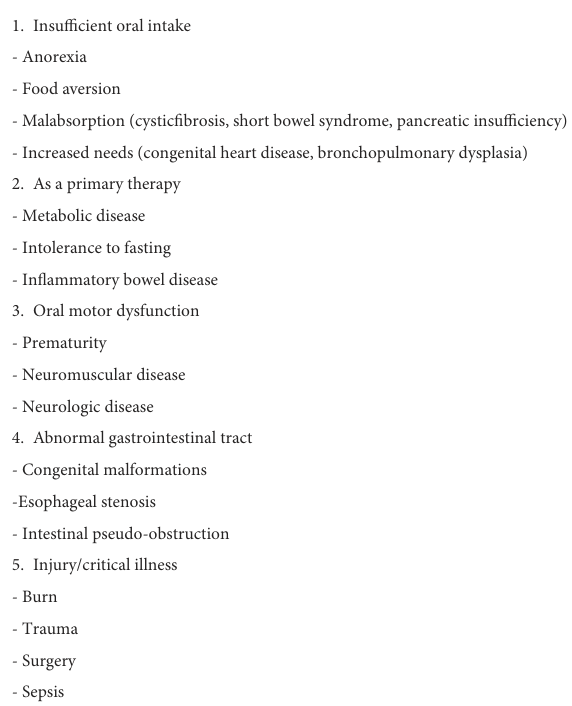
TABLE 1 Indications for tube feeding.